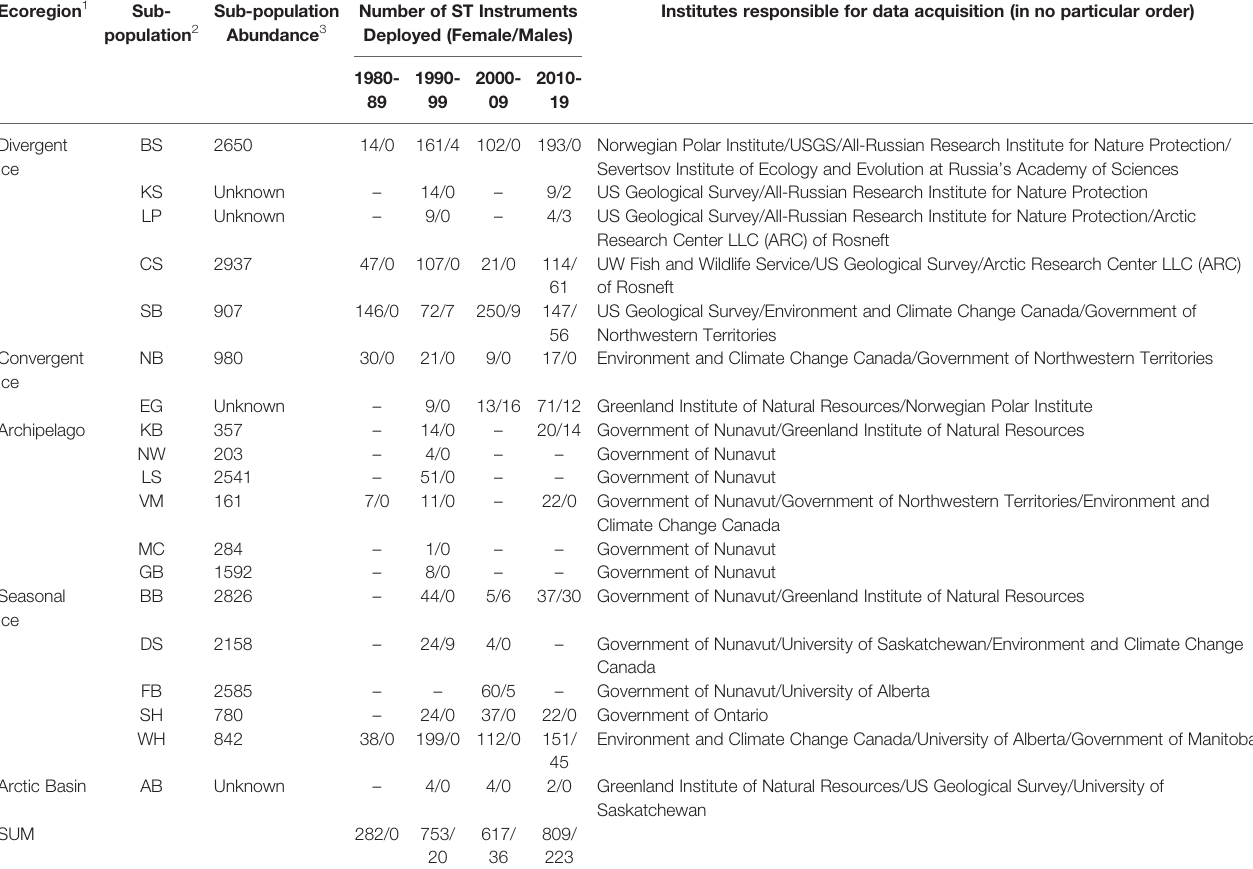
TABLE 1 | Number of bears instrumented with satellite tags (ST) (any type) by subpopulation over the last 40 years. Ecoregion 1 Sub- Sub-population Number of ST Instruments population 2 Abundance 3 Deployed